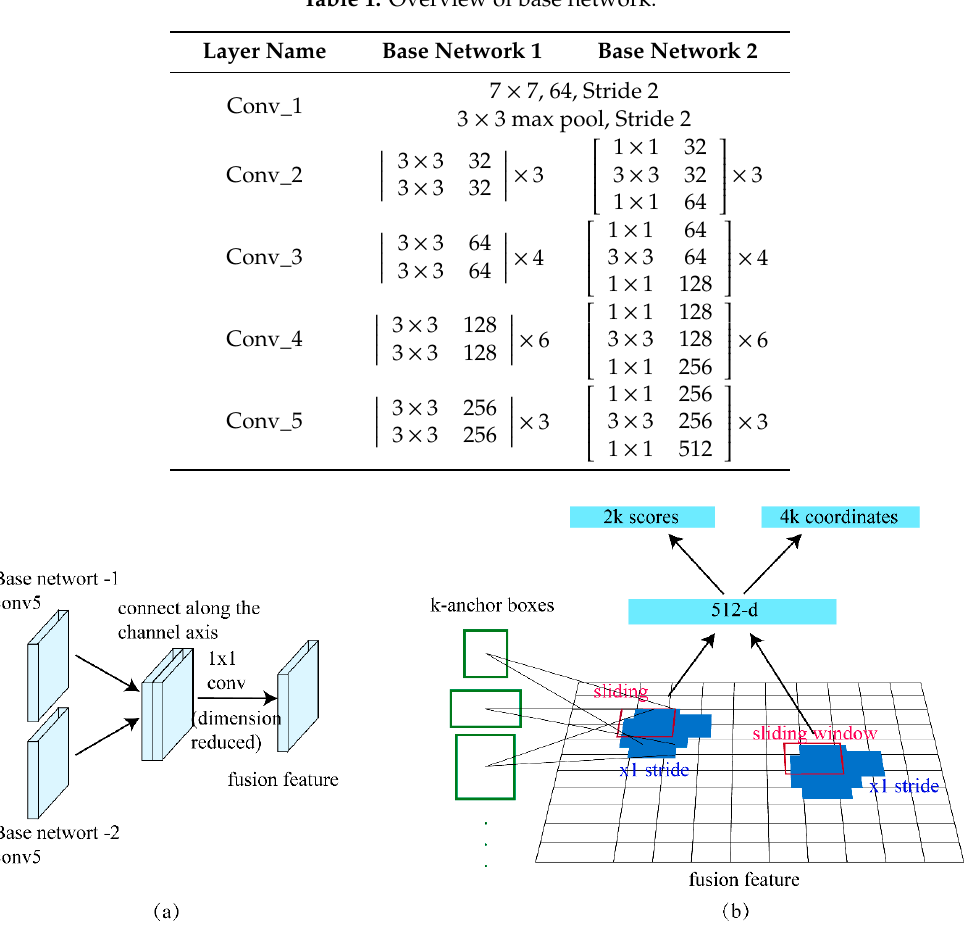
Figure 3. ( a ) We concatenate each pooled feature along the channel axis and reduce the dimension with a 1 × 1 convolution; ( b ) the region proposal network.